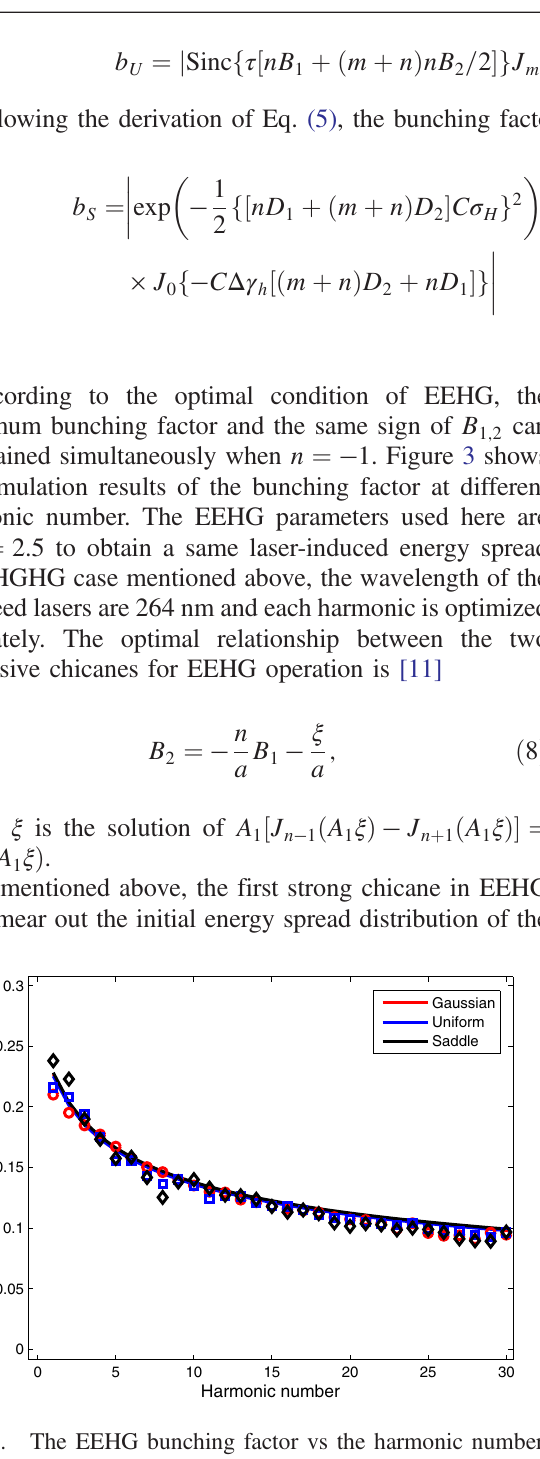
FIG. 3. The EEHG bunching factor vs the harmonic number. The solid curves are calculated from Eqs. (5) – (7), the corre- sponding colorized dots represent the 3D simulation